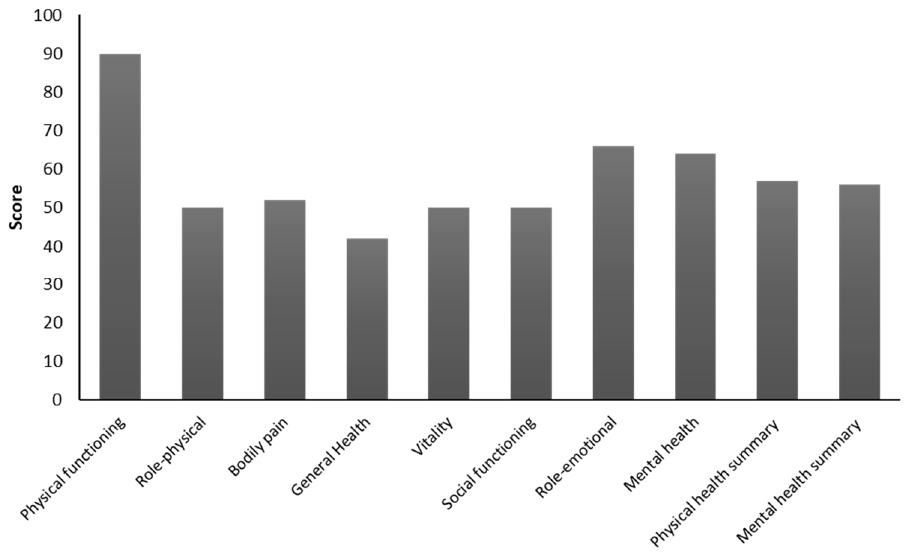
Figure 1. Health related quality of life in the study population.